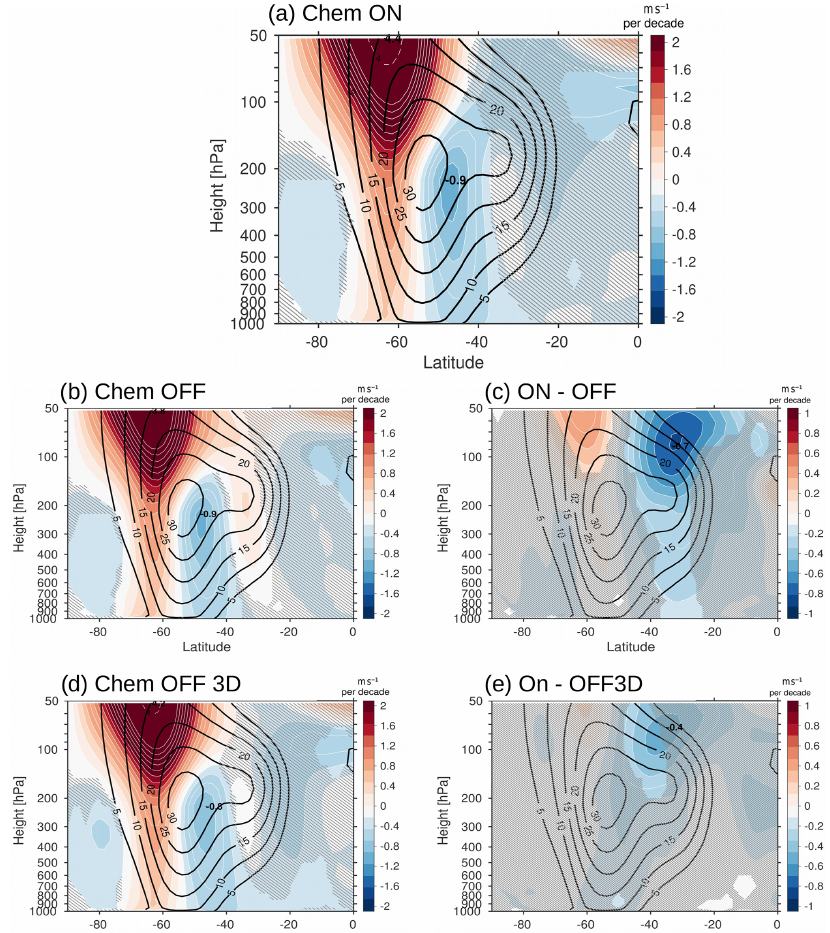
Figure 9. Zonal mean zonal wind trend in meters per second per decade in the troposphere and lower stratosphere for 1969–1998 DJF (shading) for (a) Chem ON, (b) Chem OFF and (d) Chem OFF 3D. The white contours represent values 3 ≥ ms − 1 decade − 1 with an interval of 0.2ms − 1 decade − 1 . The differences (shading) between the simulations are presented for Chem ON-OFF (c) and Chem ON-OFF 3D (e) . The particular climatologies (contours) are represented for the same period with an interval of 5ms − 1 . Statistically insignificant regions are hatched at the 5% level based on a Mann–Kendall